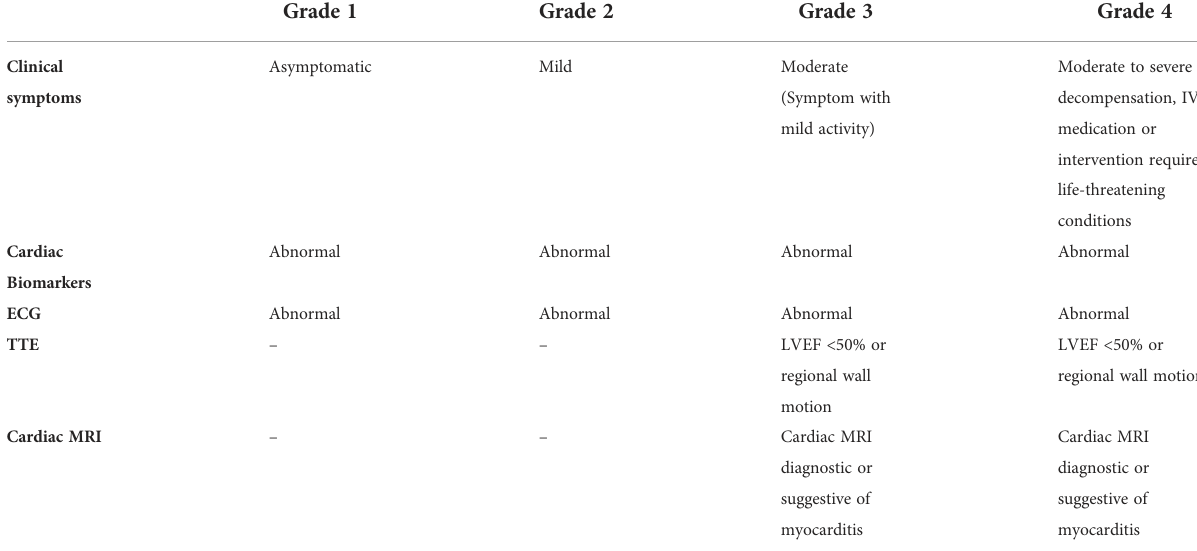
TABLE 4 ASCO grading for ICI induced myocarditis is based on biomarkers, ECG, imaging and clinical presentation